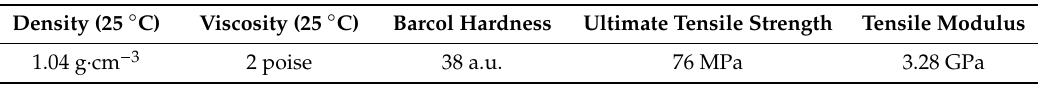
Table 2. Fundamental properties of the urethane-acrylate thermoset resins (UATR) (according to the manufacturer’s datasheet).